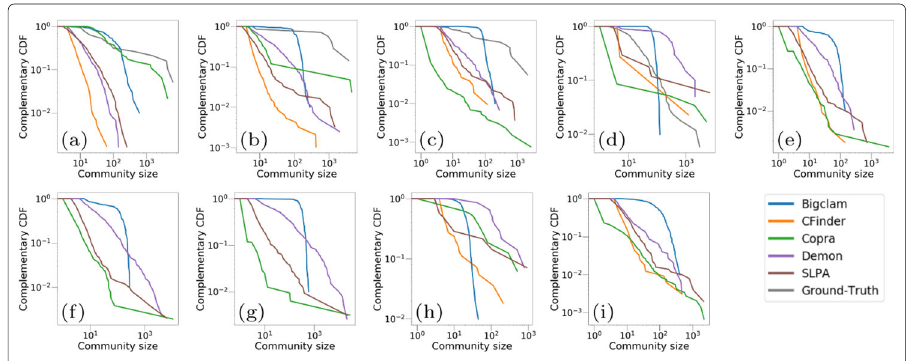
Fig. 29 Community size identified by the methods considering the real-world networks: a Amazon; b DBLP; c LiveJournal; d Youtube; e CAGrQc; f CAHepPh; g CitHepTh; h Email; i Keys